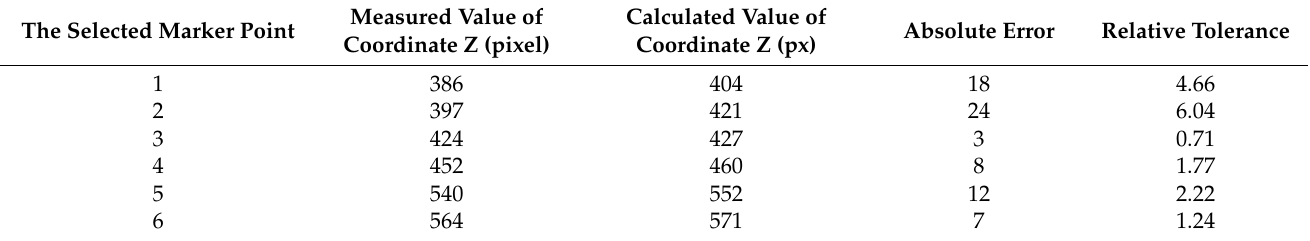
Table 5. Verification result of the H. cunea sample. The truth value (measured value) and the calculated value of coordinate Z are presented in pixel, and the absolute and relative errors are